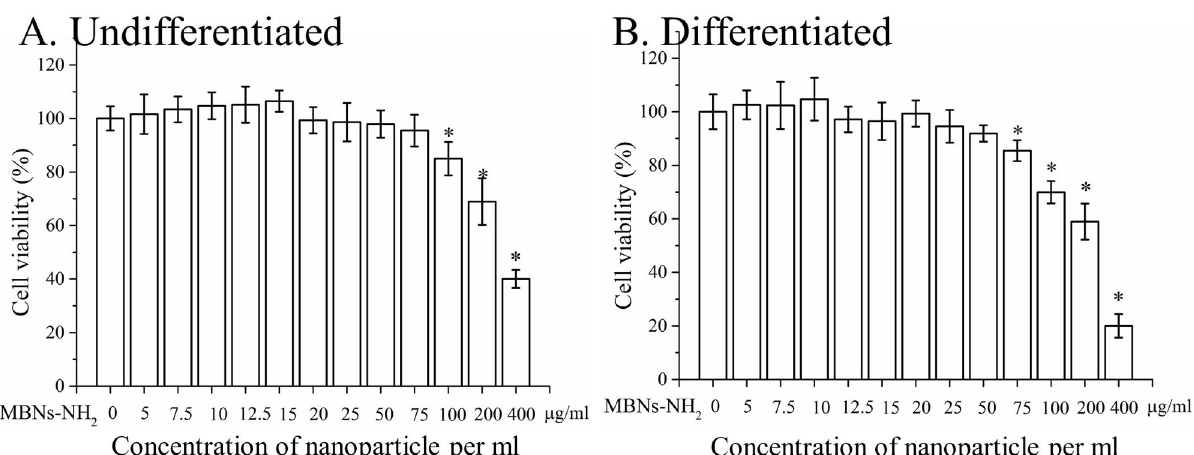
Fig 2. Cell viability after 24 h incubation with various concentrations of MBNs – NH 2 in (a) undifferentiated or (b) differentiated rDPSCs. After cells were plated at a volume of 100 μ L of 10 5 cells per well on a 96-well plate for 24 h, 5, 7.5, 10, 12.5, 15, 20, 25, 50, 75, 100, 200, or 400 μ g MBNs – NH 2 per mL of initial 10 5 rDPSCs (0.5, 0.75, 1, 1.25, 1.5, 2, 2.5, 5, 7.5, 10, 20, or 40 μ g MBNs – NH 2 to 100 μ L of 10 4 rDPSCs) was incubated in each well of a 96-well plate for an additional 24 hours with conventional supplemented media or odontogenic supplemental media. After 1 day, cell viability was determined using water-soluble tetrazolium based on the percentage of the optical density (450 nm) value in the experimental group versus the non-treated control. Assays were independently performed in triplicate. Representative averages (n = 5) and SD were recorded. * Significant difference vs. non-treated control (p <